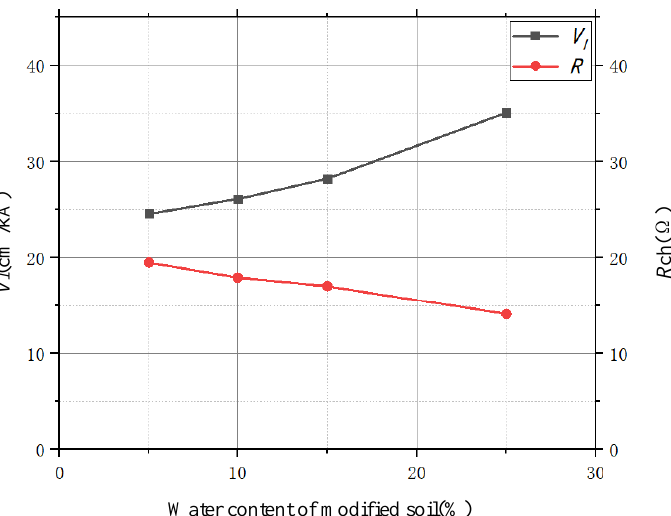
Figure 23. Curve of V I with water content of modified soil.